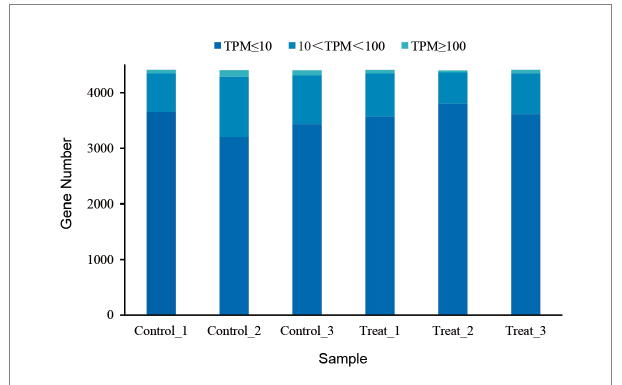
FIGURE 4 Gene expression abundance of the RNA-seq samples.